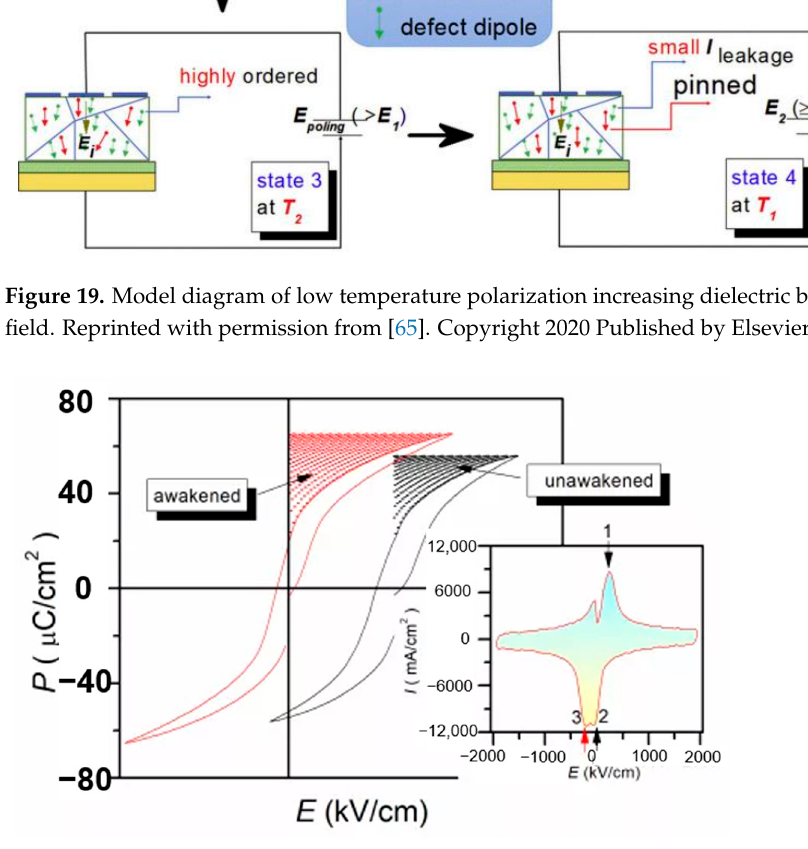
Figure 20. Comparison of energy storage density before polarization (wake up) and after polarization (wake up). Reprinted with permission from [65]. Copyright 2020 Published by Elsevier Ltd.